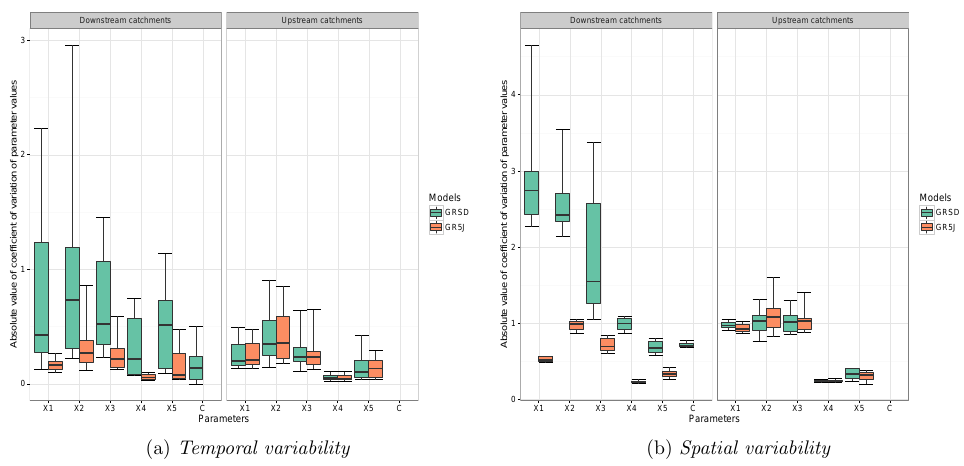
Figure 6. Variability of parameters values among calibration periods within one catchment (64 catchments summarized by boxplots, a ) and variability of parameters values among catchments within one calibration period (21 calibration periods summarized by boxplots, b ). Boxplot limits describe the 10th, 25th, 50th, 75th and 90th